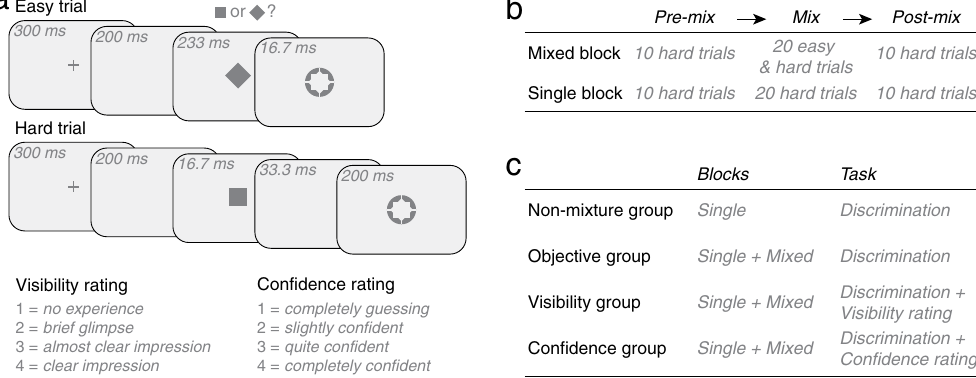
the subjective task, to rate either target visibility or choice confidence. Based on the presence or absence of 1) easy trials and 2) a subjective task, participants were separated into 4 groups ( n = 28 each): a non-mixture (i.e., no easy trials), identification-task-only group (hereafter, non-mixture group); and three mixture groups—an identification-task-only group; an identification plus visibility rating group; an identification plus confidence rating group (hereafter, objective , visibility and confidence groups). First, the non-mixture group went through 28 blocks of hard trials without easy trials (single blocks); the three mixture groups went through 28 interleaving single and mixed blocks (Fig. 1b). A mixed block consisted of 10 hard trials (pre-mix), 20 alternating easy and hard trials (mix), and then 10 hard trials (post-mix). Importantly, interleaving mixed and single blocks allowed us to isolate and track sustained and transient effects from easy trials: sustained changes as indexed by changes in performance across single blocks; transient changes as indexed by changes in performance within a given mixed block. Second, the non-mixture group and the objective group completed only the identification task; the visibil- ity group and the confidence group did the same experiment as the objective group, but additionally were asked to indicate, on a trial-by-trial basis, their subjective experience regarding target visibility or choice confidence on a 4-point scale (Fig. 1a). Our first objective was to ascertain that any sustained changes in single blocks were due to the mixture of easy trials in mixed blocks rather than other factors (such as mere practice). Therefore we tracked and compared per- formance in single blocks between the objective group and the non-mixture group, which differed only in the mixture of easy trials. As Fig. 2a (left) shows, the mixture of easy trials bestowed a clear performance advantage that emerged quickly and persisted to the end of the session (main effect of group: F (1, 54) = 81.38, p < 0.001, 2 = 0.60; main effect of block pairs: F (13, 702) = 15.21, p < 0.001, η 2 = 0.22; interaction: F (13, 702) = 9.15, η p p 2 = 0.14). To estimate and compare the sustained effect, we fitted the data presented in Fig. 2a using p < 0.001, η p the formula, A + B (1 − e − ( t − 1 )/ T ), with 3 parameters: A , initial performance; B , maximum amount of learning; and T , the time constant for learning (see Section “Model method” in Supplementary Materials). Although in both groups this learning model outperformed a model that assumed no learning, the learning effect ( B ) was much more pronounced in the objective group (mean ± one standard deviation, SD : 13.6% ± 3.5%) than in the non-mixed group (2.4% ± 3.1%). The estimated learning rating ( T ) revealed that it took about 2.6 ( ± 1.2) blocks for the objective group to reach 95% of maximum learning (see Supplementary Table S1 and Supplementary Section “Model statistics”). For the two rating groups, sustained changes were also evident, emerging within the first few single blocks (Fig. 2a, right). Performance then tapered off. Performance deterioration within a single testing session is not uncommon 7 , which can be attributed to sensory adaptation or fatigue. Because sensory adaptation depends on the number of trials and the number of trials was the same for the two non-rating groups and for the two rating groups, their differences were likely due to a difference in the fatigue effect. Fatigue likely arose from the demand- ing nature of the dual task and the longer time required for completing the study (about 1.5 hours; cf., one hour for the two objective-task-only groups). Learning therefore was modelled prior to performance decline (cut off liberally at the block with the highest accuracy; hence 5 th block in the visibility group, 6 th block in the confi- dence group). The estimated learning effect ( B ) was 10.6% ± 3.9% for the visibility group (in ratings: 0.14 ± 0.20) and 7.6% ± 4.0% for the confidence group (in ratings: 0.12 ± 0.11), higher than the non-mixture group (see Supplementary Table S1 and Supplementary Section “Model statistics”). To probe transient effects, we tracked trial-by-trial changes in performance within a mixed block, as compared with changes within a single block. As Fig. 2b shows, in both accuracy and ratings, mixture of easy trials led to rapid improvement in the mixed block, which gradually decayed when easy trials were removed. Going into the